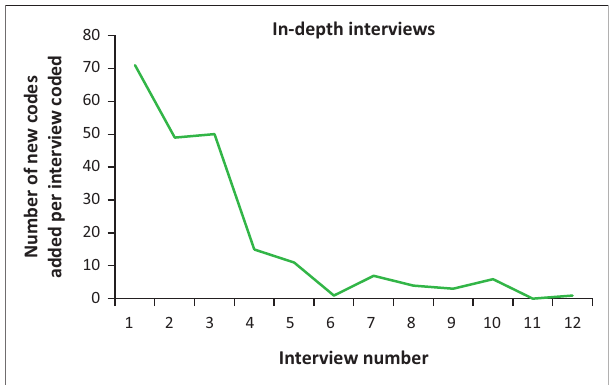
FIGURE 2: New code generation trend per interview.